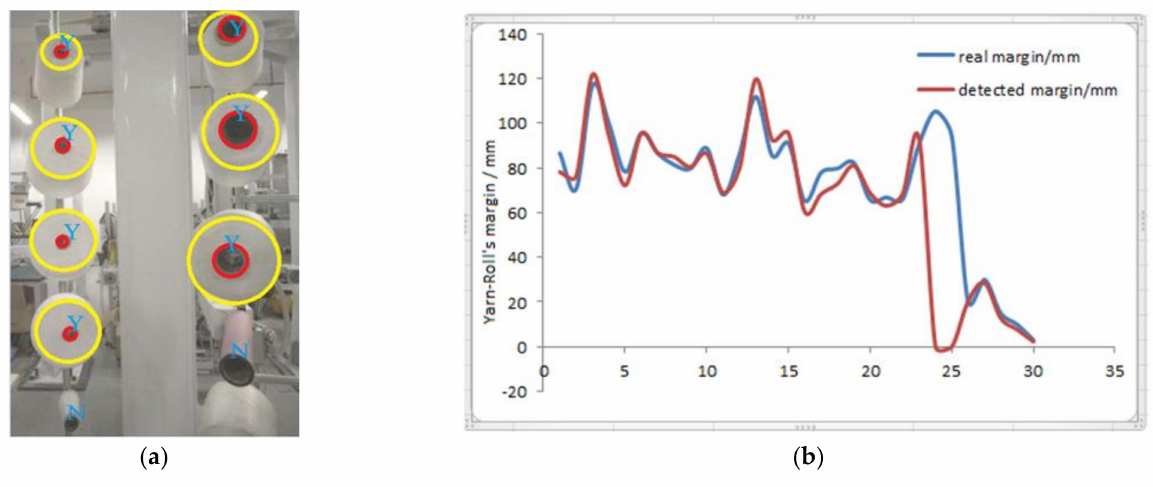
Figure 12. ( a ) The outputs of model 1 and model 2 are drawn in image. ( b ) The comparison between the real thread roll’s margin and the calculated margin. Red line is the margin detected from 30 different thread rolls, blue line is its real